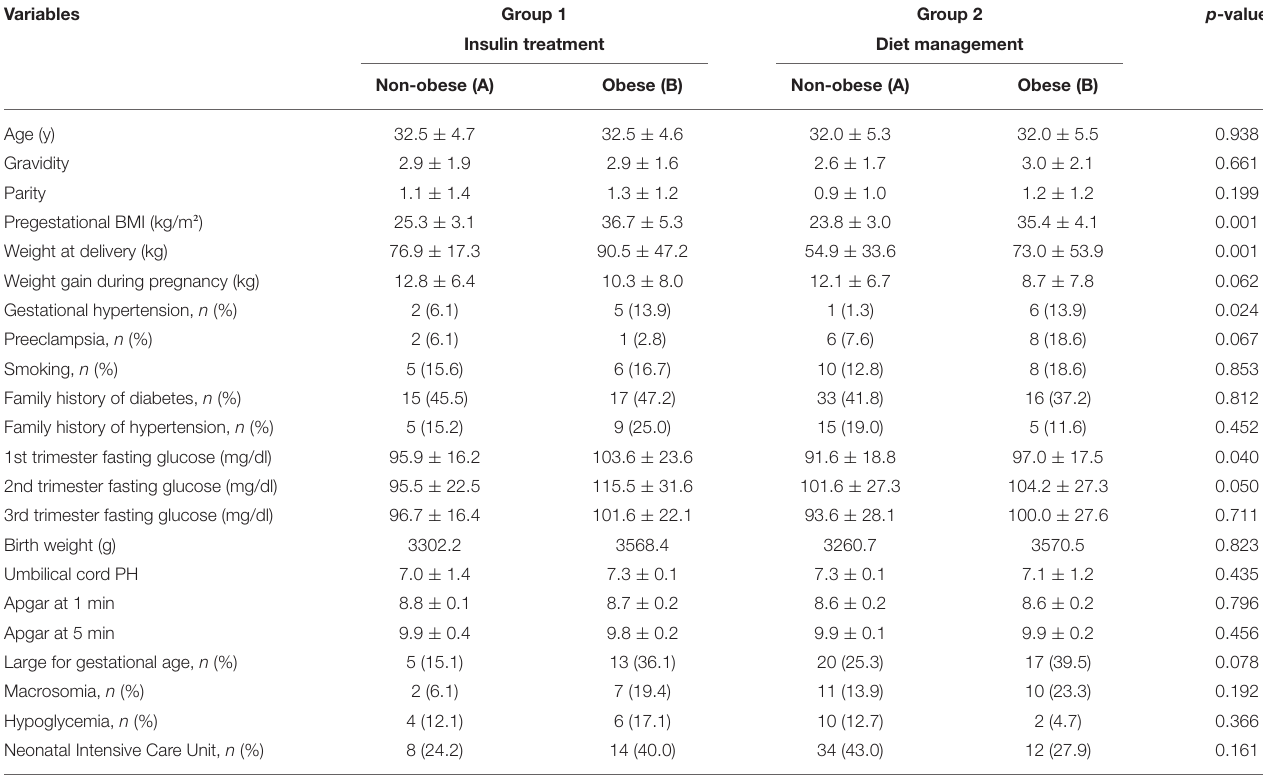
TABLE 1 | Maternal and neonatal characteristics according to the study